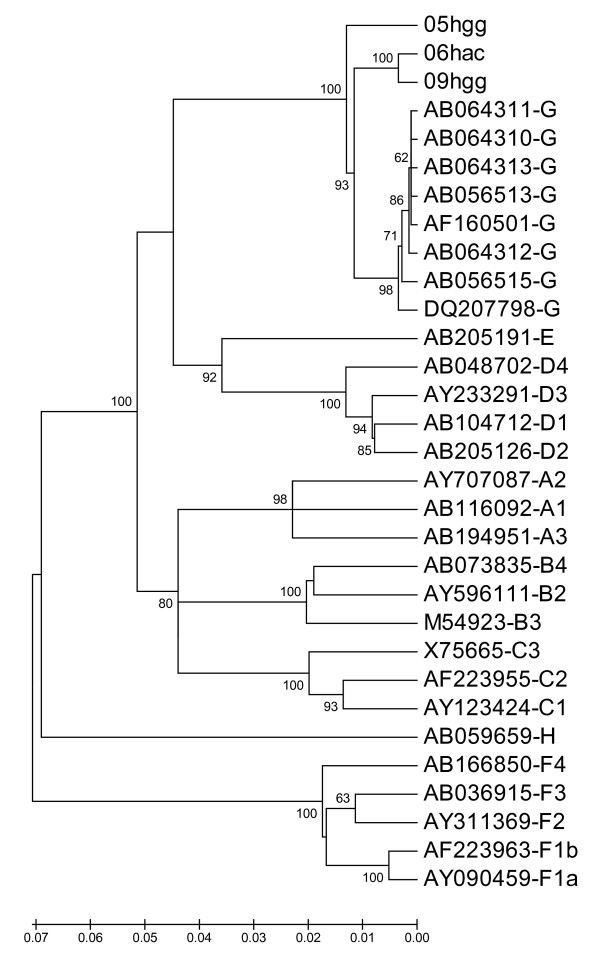
Phylogenetic tree based on full-length nucleotide sequences. Isolates from this work are named 05-hgg, 06-hac and 09-hgg. The other isolates are indicated by their GenBank accession number, followed by genotype/subgenotype designation. The horizontal bar shows a genetic distance scale.